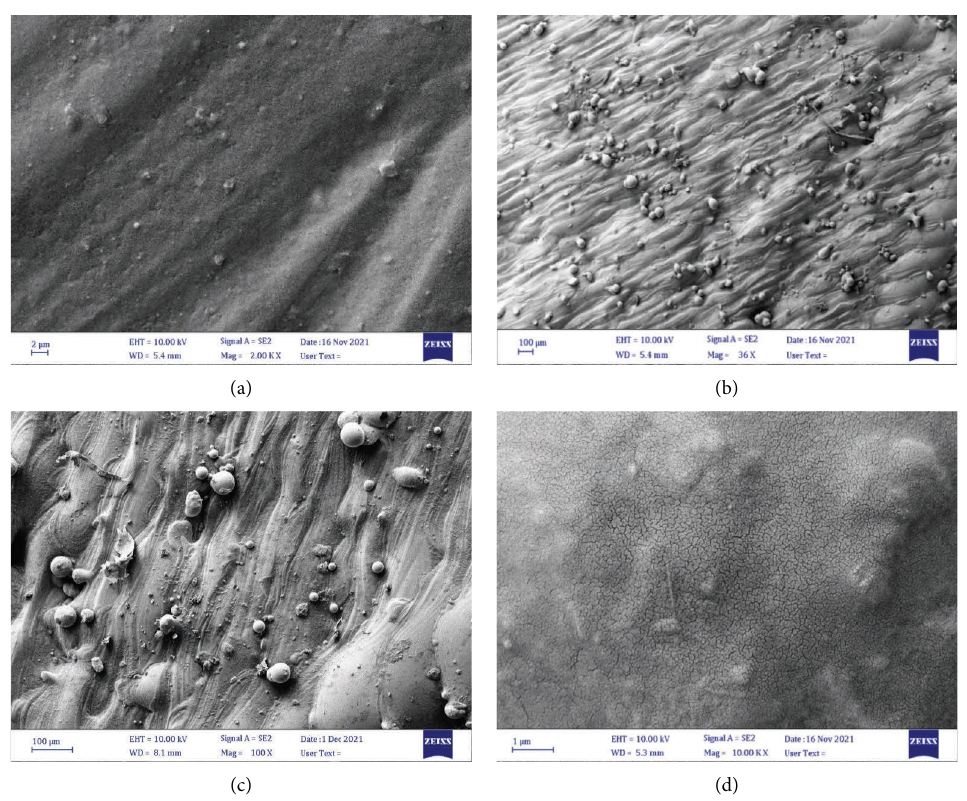
Figure 4: (a) FESEM image of the sample. (b) FESEM image of sample product by SLM with magnifcation of 36X. (c) FESEM image of sample product by SLM with magnifcation of 100X. (d) FESEM image of sample product by SLM with magnifcation of 10.00